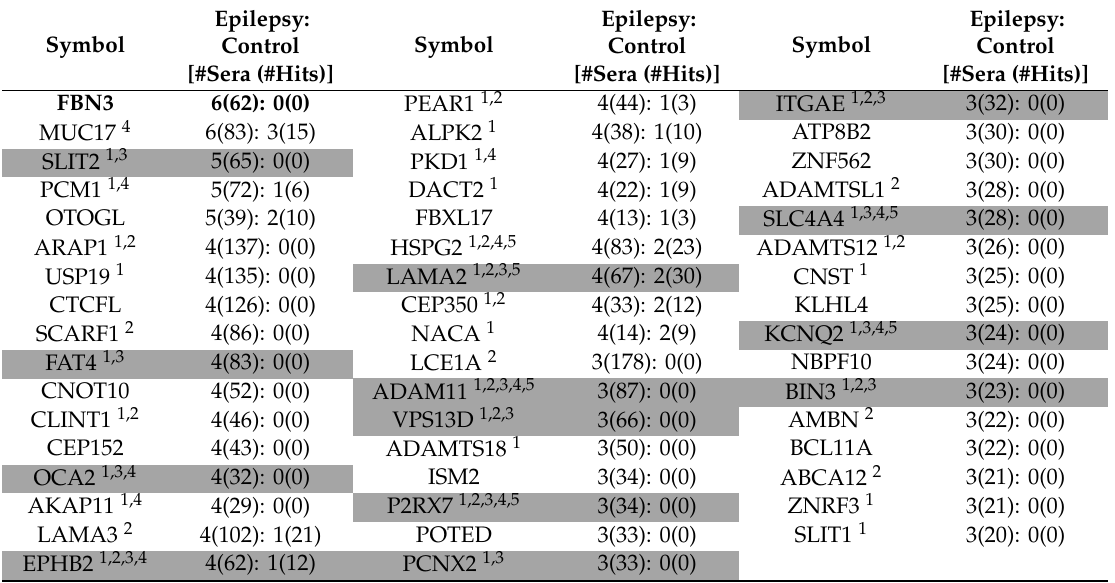
Table 3. Top 50 Epilepsy over Control proteins with 2 × or better sera and 1.5 or better MS / MS